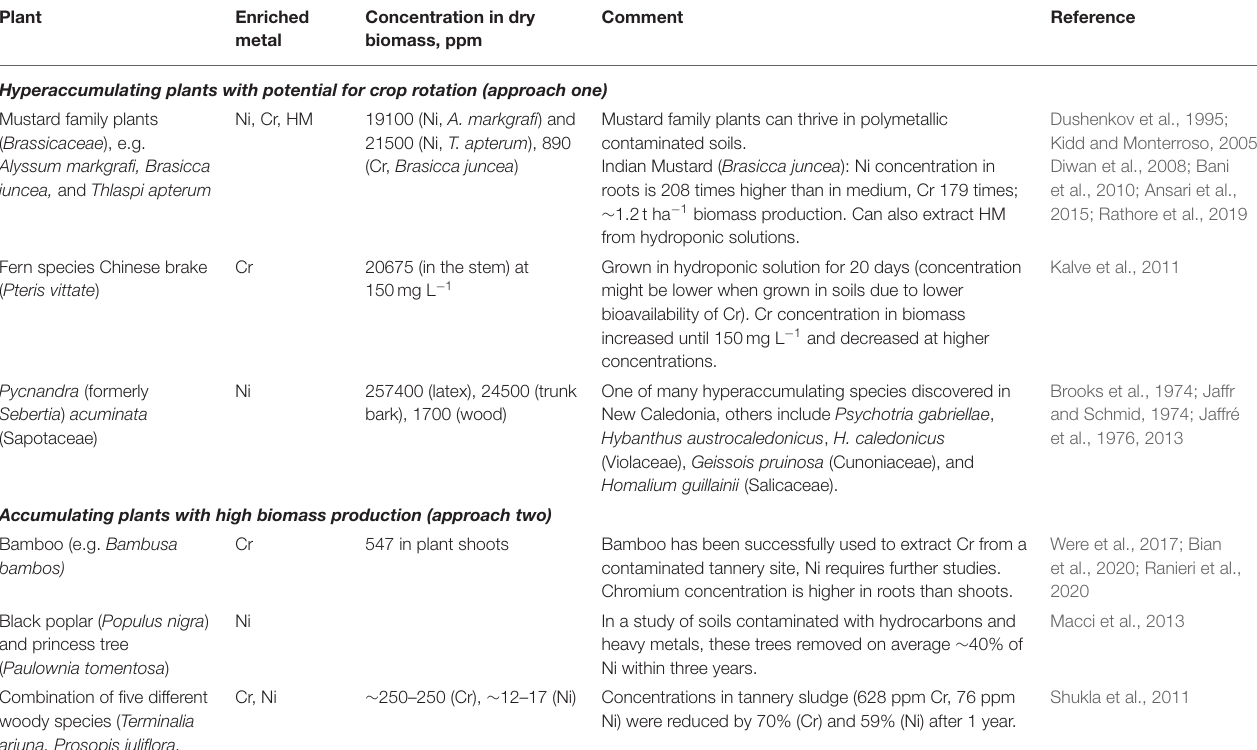
TABLE 1 | Selected plants that have been used to remove Cr and/or Ni from soils or water and might be useful in one of the three phytoprevention scenarios outlined in the main